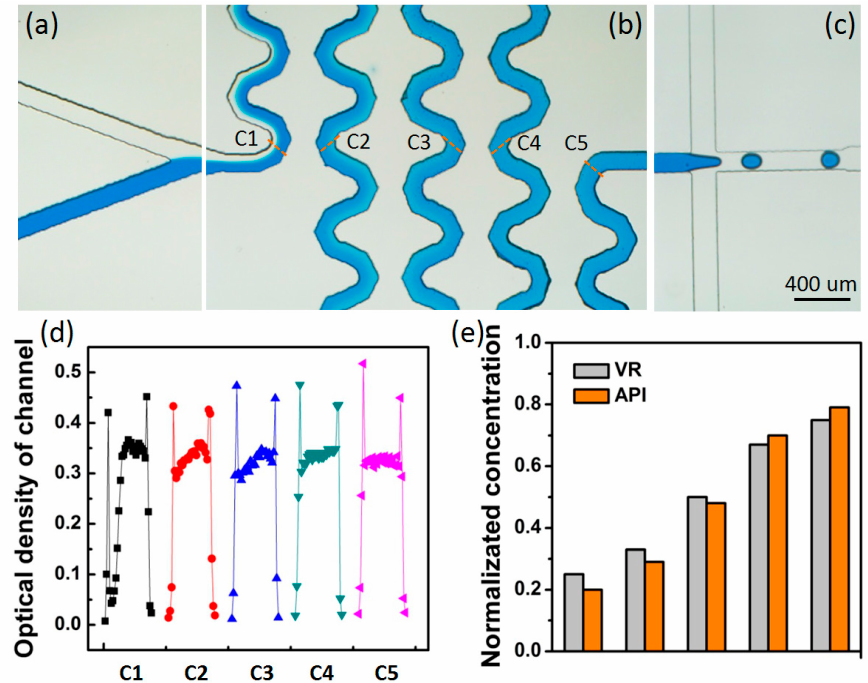
Figure 2. Food dye solution and DI water were ( a ) merged in the Y-shape channel; ( b ) well-mixed in the following S-shape channel; ( c ) Droplets were generated in the flow-focusing manner; ( d ) The optical density analysis of the merging solution from C1 to C5 in the mixing channel with the same mixing ratio and ( e ) The solutions with a combination of the concentration gradient of food dye were provided by the desired volumetric ratio (VR) weighed and tested by the absorption percentage of the light (API)